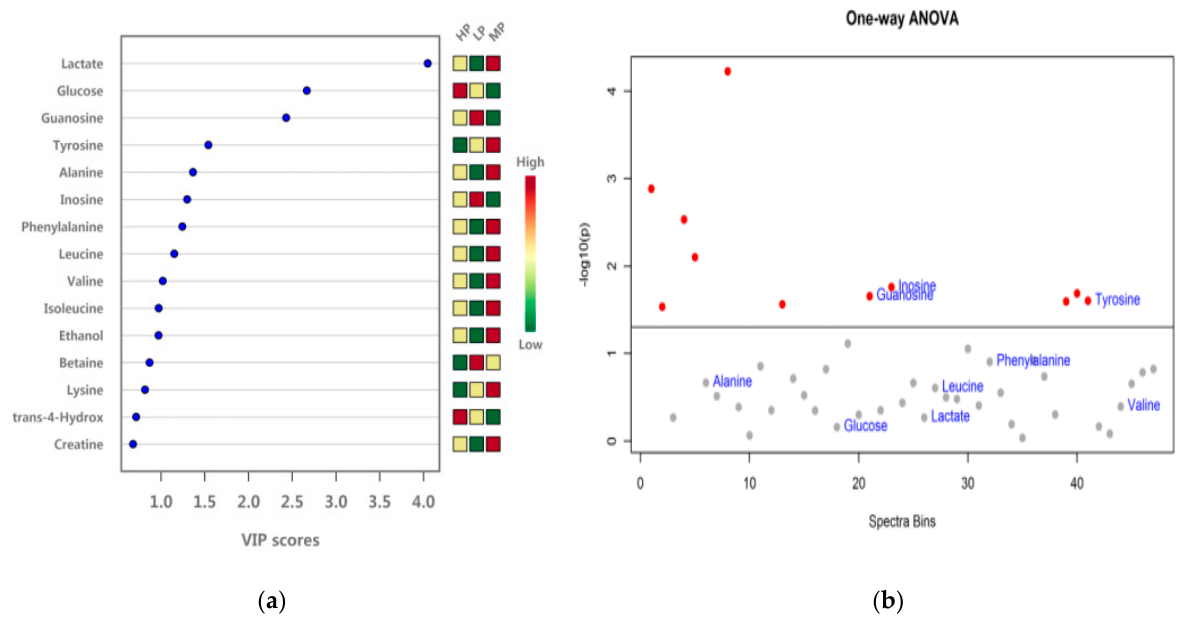
Figure 11. Metabolites VIP Analysis and ANOVA test of metabolites (VIP > 1) in serum. ( a ) Metabolites VIP Analysis; ( b ) one ‐ way ANOVA test of metabolites (VIP > 1). Metabolites above the dotted line had significant differences.